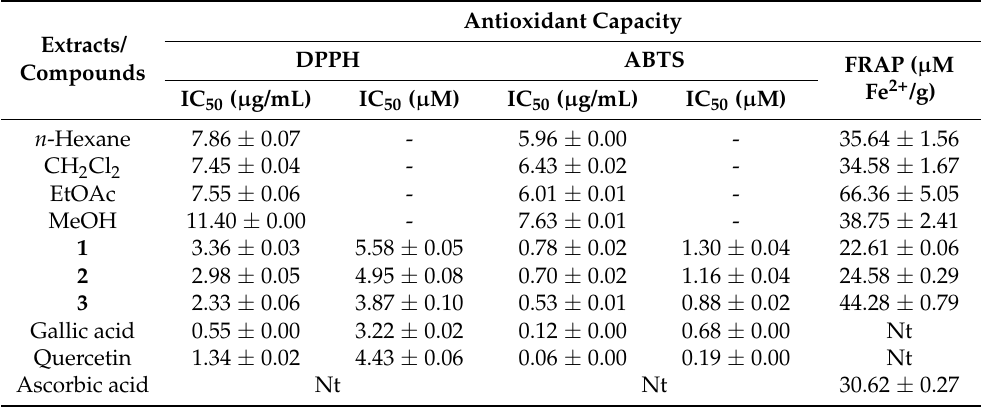
Table 3. The antioxidant activities of G. celebica root bark extracts and isolated compounds 1 – 3 . Extracts/